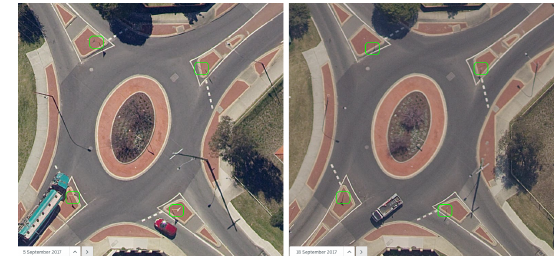
Figure 7. The left image shows a high-resolution satellite image from the 5 th September 2017, and the right image shows the same road asset section with data from the 18 th September 2017 (source: https://www.spookfish.com). The green rectangles indicate the location of placed GIVE WAY